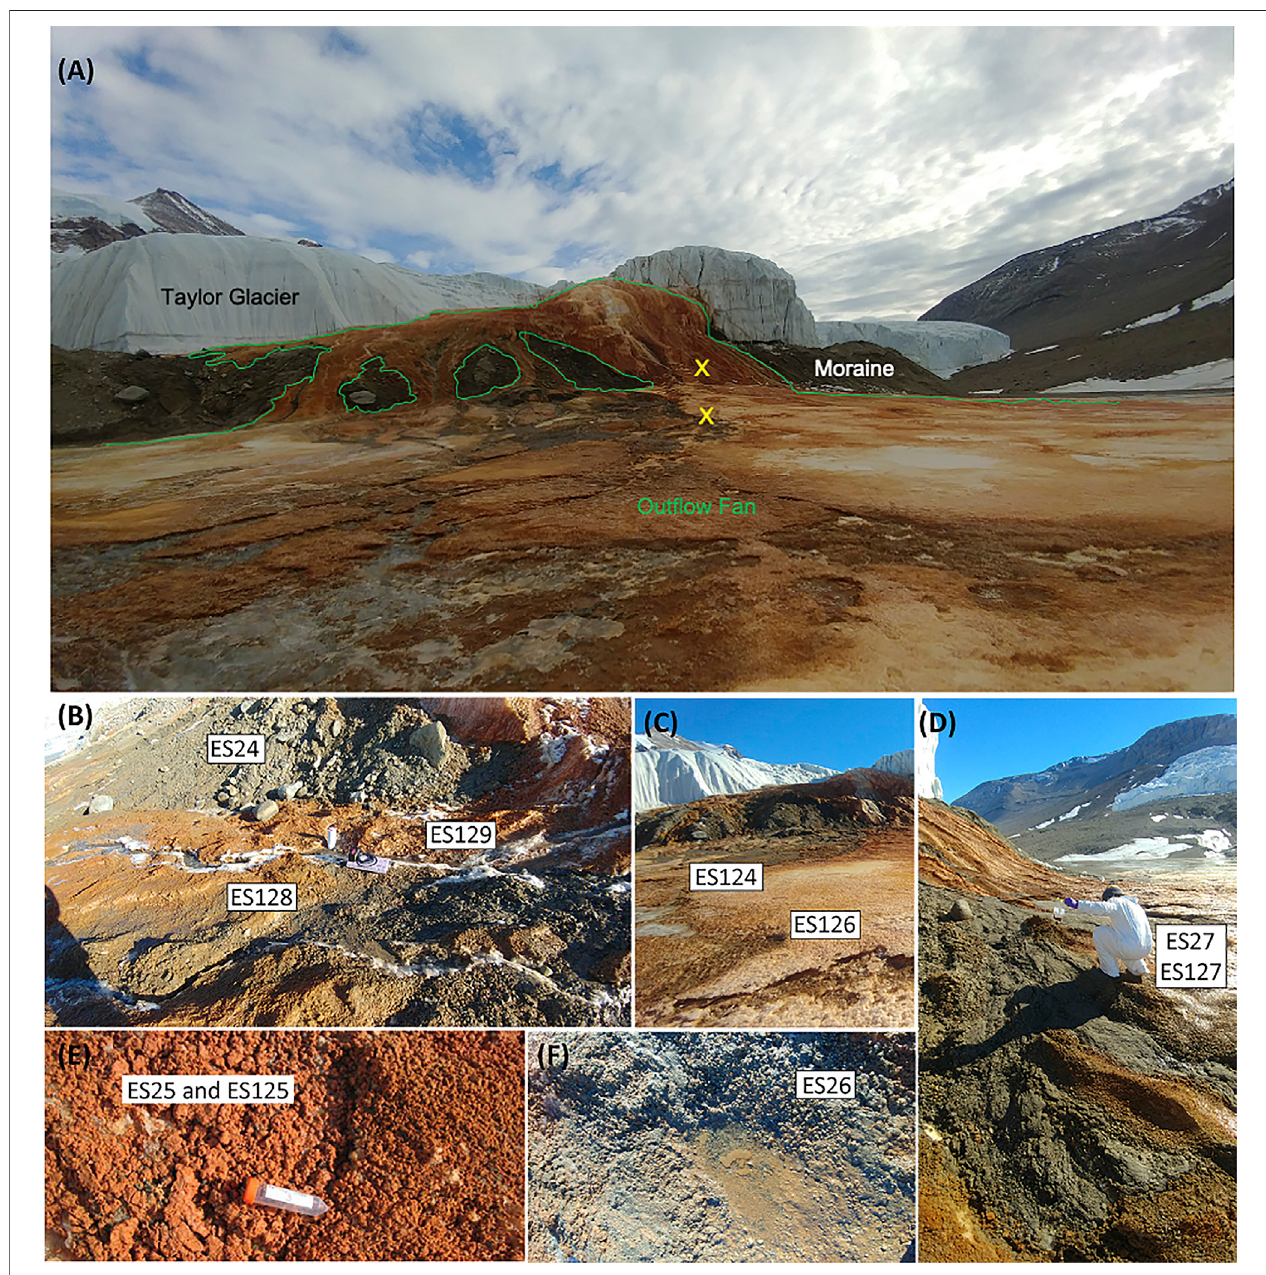
FIGURE 1 | (A) The Blood Falls out fl ow fan (77.7167 ° S, 162.2667 ° E) at the terminus of the Taylor Glacier in November, 2018. (B – F) Diversity of samples from the Blood Falls discharge analyzed in this study. See descriptions in Table 1